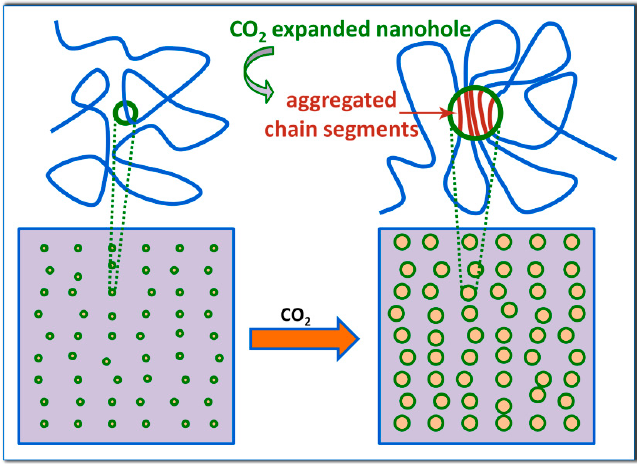
Figure 11. Schematic (not to scale) representation of the CO 2 expaned nanoholes of free volume in glassy PLA samples. Upon adsorbing CO 2 , the free volume expansion was induced, leading to small clusters of parallel-aligned chain segments, which transformed to critical nuclei for inducing later crystal growth upon thermal annealing. The two boxes and holes inside them (lower row) correspond to limited parts of the samples and some free volume sites, respectively. Note that the real free volume holes are everywhere and are roughly speaking the intersegmental spaces for segmental motion, and actually a distribution of sizes exist.